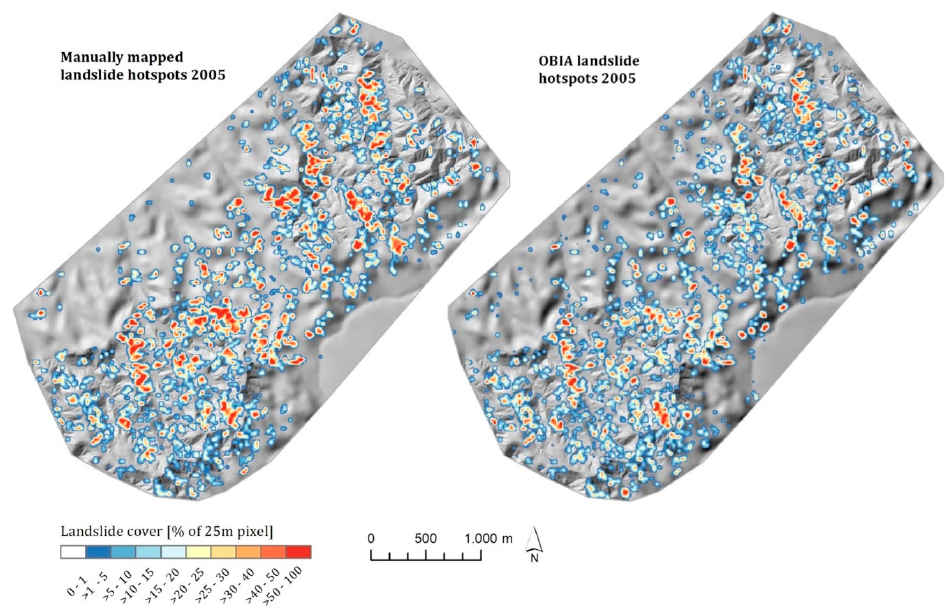
Figure 7. Comparison of landslide hotspot maps based on the manual landslide mapping results ( left ) and on the OBIA results ( right ) for 2005 displayed on a shaded relief.